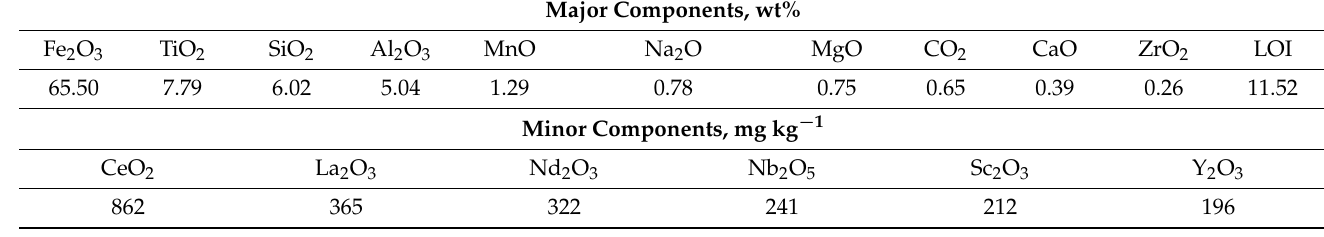
Table 1. Chemical composition of the red mud obtained by alkali fusion-leaching method (RMF). Major Components, wt%